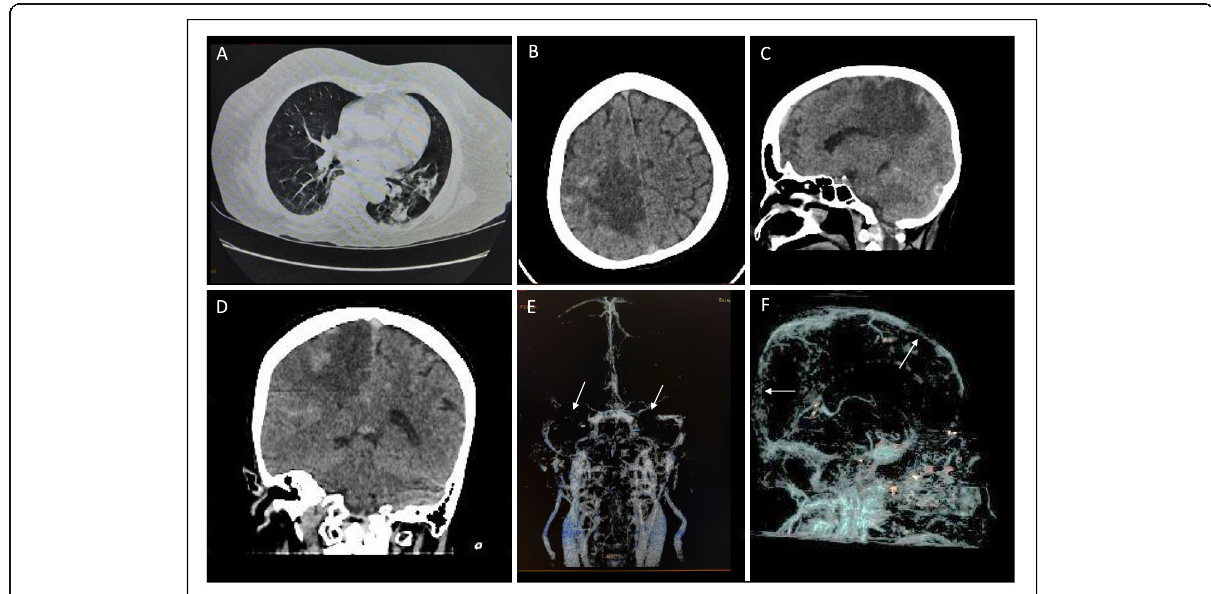
Fig. 1 Acute onset of cerebral sinus venous thrombosis in COVID-19. A Axial thorax CT-scan showed ground-glass opacity and subpleural bilateral, with a fibrotic appearance in the left lung. B Axial head non-contrast CT-scan (NCCT scan) showed, parenchymal edema on the right parietal lobe and hyperdense cortical veins. C Sagittal NCCT scan showed parenchymal edema on the right parietal lobe and hyperdense superior sagittal sinus. D Coronal head NCCT scan showed parenchymal edema on the right parietal lobe and hyperdense superior sagittal sinus. E , F Brain CT venography showed, filling defect at SSS, TS bilateral, sigmoid sinus